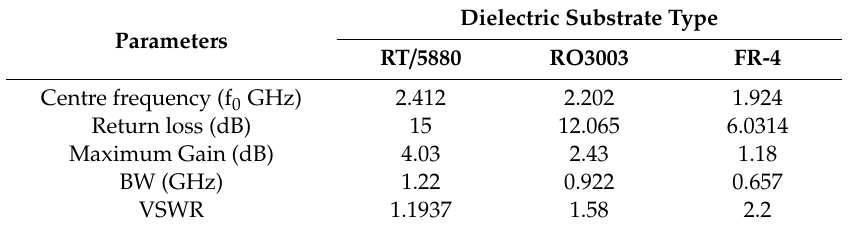
Table 2. Comparison of different parameters for three different dielectric substrate materials.